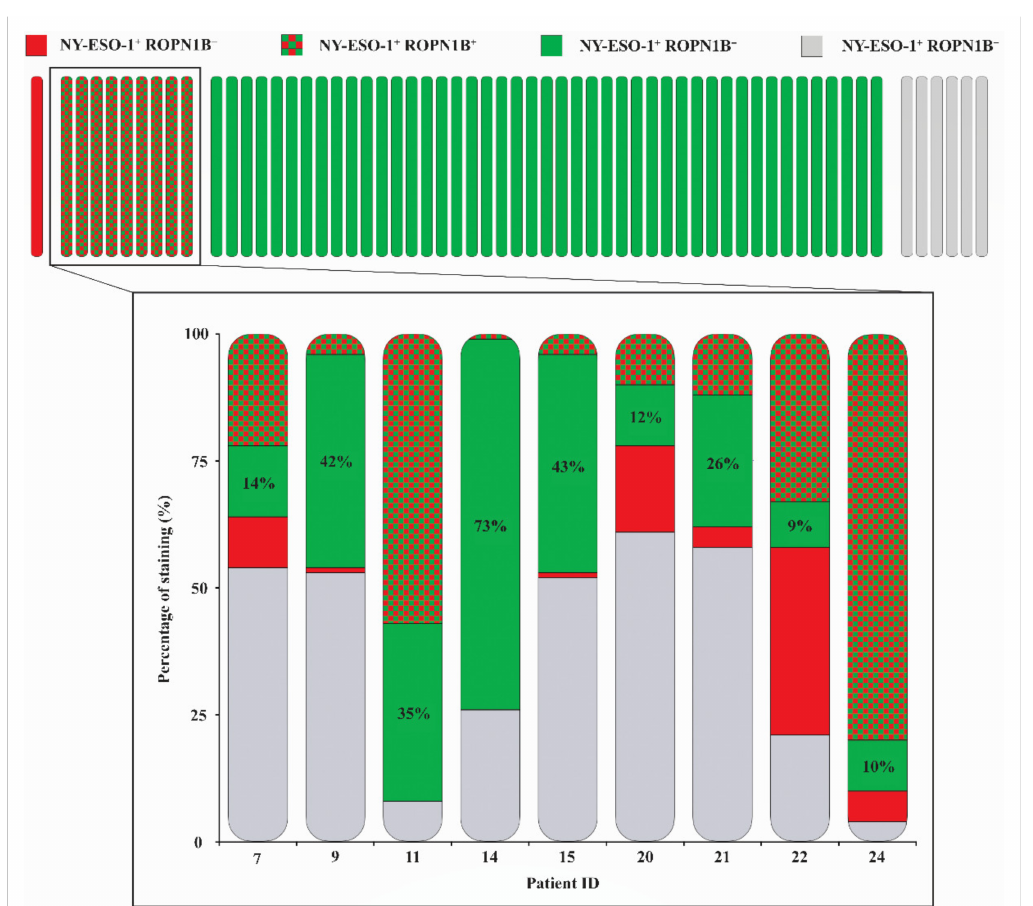
Figure 3. Tumour cell coverage of ROPN1B and NY-ESO-1 expression in investigated melanoma tumours. Upper panel indicates number of tumours with any expression of NY-ESO-1 alone (red), NY-ESO-1 and ROPN1B (chequered red and green), ROPN1B alone (green) or neither (grey) across the cohort. Magnified panel depicts quantitative distribution of NY-ESO-1 and ROPN1B staining relative to SOX10+ melanoma cells across patients displaying both NY-ESO-1 and ROPN1B expression. Percentages on bars show ROPN1B expression